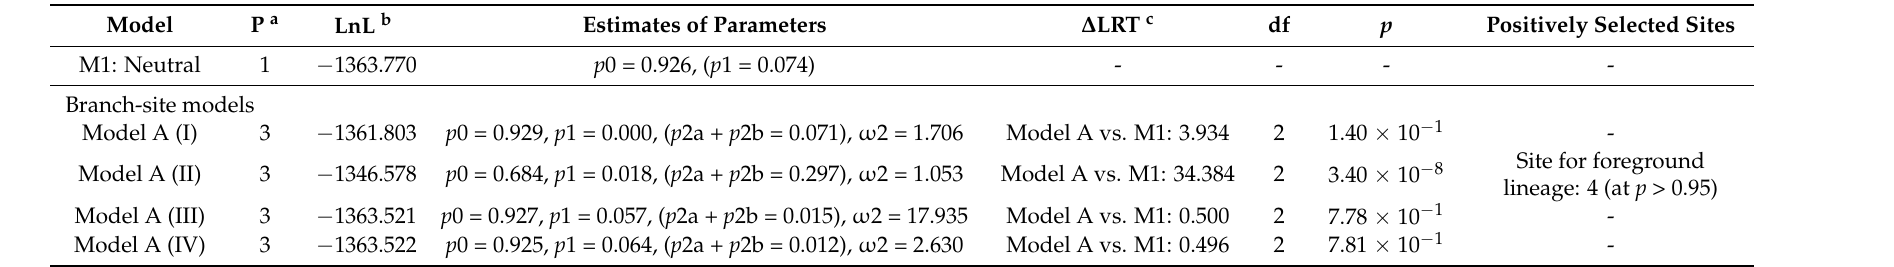
Table 3. Parameter estimates and likelihood ratio tests for the branch-site